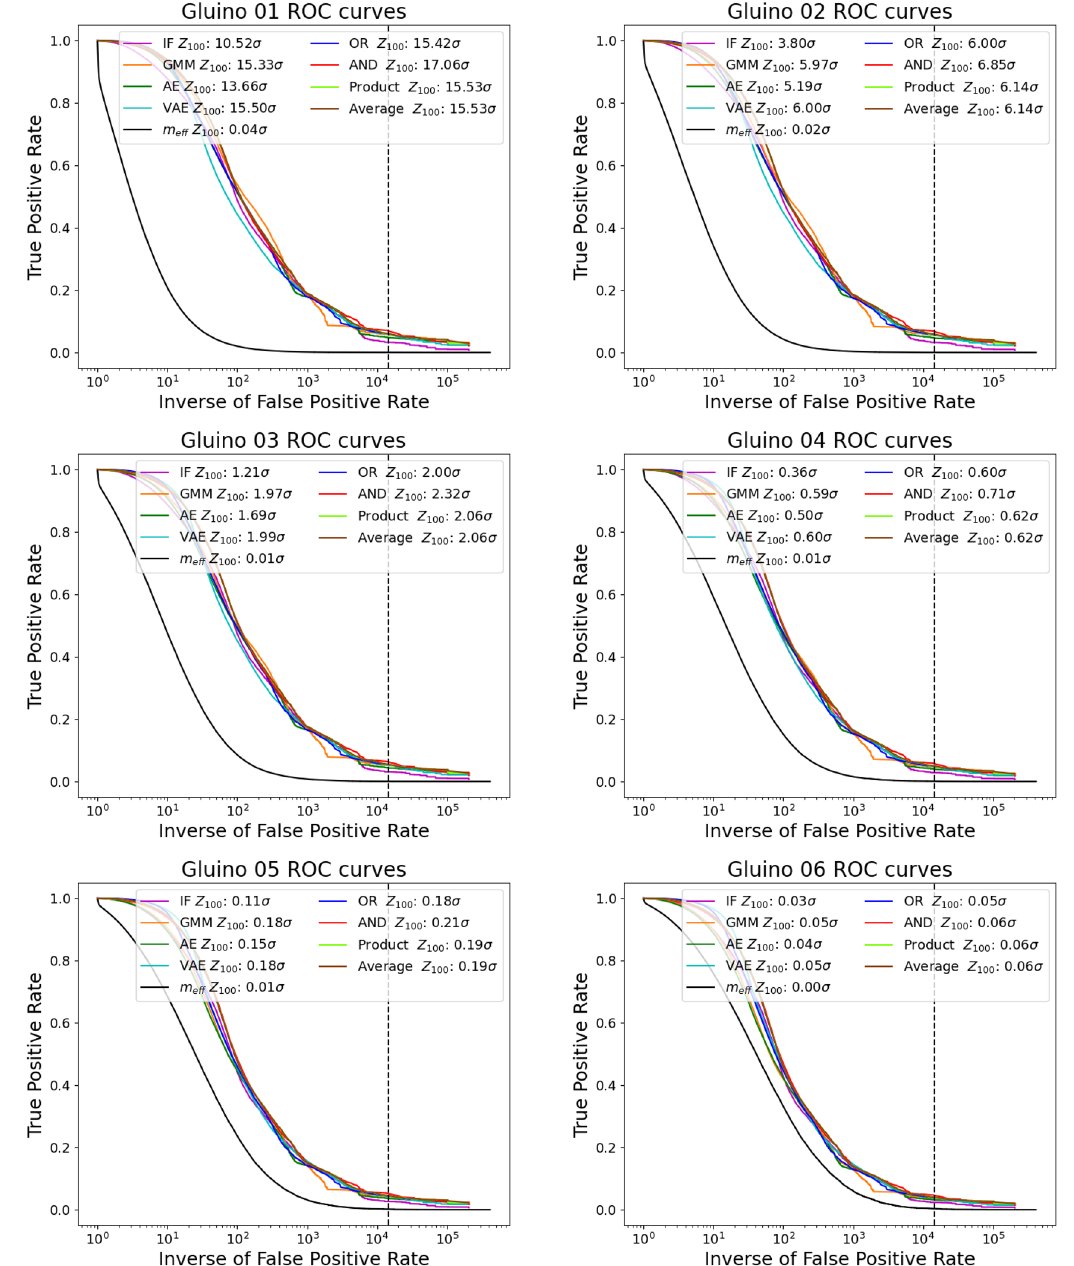
Figure 5 . ROC curves for the gluino signals (table 1) for the algorithms applied on latent space representations. For further information see figure